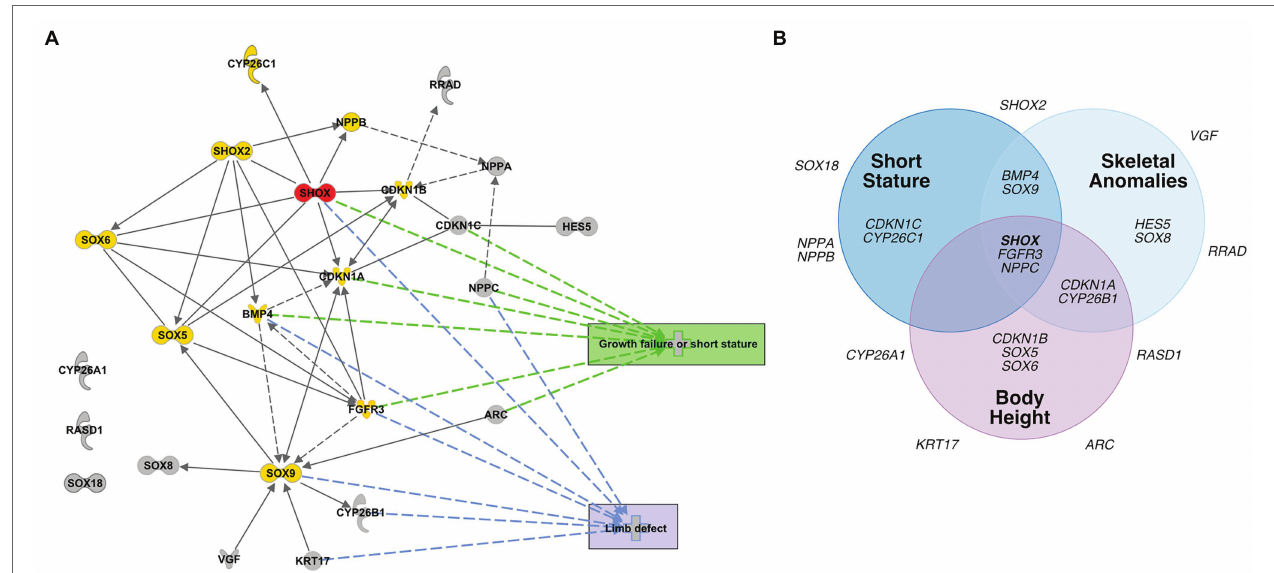
FIGURE 5 | Database analyses of SHOX-regulated genes. (A) Network-based pathway analysis of SHOX-regulated genes using the Ingenuity pathway analysis (IPA) software. SHOX is highlighted in red. Known SHOX-associated genes are shown in yellow. Novel SHOX-regulated genes are shown in gray. Direct regulations are indicated by arrows and interactions as lines; indirect regulations or interactions are presented as dotted arrows/lines, respectively. The most important annotated pathways relevant to SHOX-associated diseases or function are highlighted in green (genes involved in growth failure and short stature) and blue (genes involved in limb defects). (B) Gene-disease association according to DisGeNET. Venn diagram showing associations between SHOX and 23 SHOX-regulated genes with respect to skeletal phenotypes based on the DisGeNET database (https://www.disgenet.org/home/; Pinero et al.,